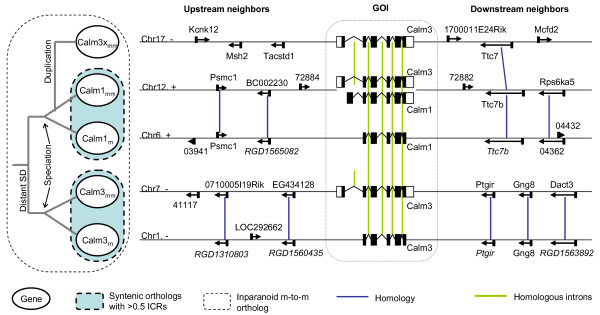
One example of many-to-many Inparanoid ortholog groups where a SD event proceeded mouse-rat speciation. The Ensembl gene IDs of GOI are ENSMUSG00000001175 (Calm1mm), ENSMUSG00000019370 (Calm3mm), ENSMUSG00000036438 (Calm3xmm), ENSRNOG00000004060 (Calm1rn), ENSRNOG00000016770 (Calm3rn). The gene structures and neighboring gene orders of five Calm1 and Calm3 genes in mouse and rat genomes are shown. The event tree on the left side is predicted based on the local synteny. SD: segmental duplication. Genes are shown corresponding to the strand of GOI in order to show the homology between neighboring genes. Five digits gene IDs are the last five digits of Ensembl gene IDs. IDs in italic typeset are predicted ones. Homology between two neighboring genes are defined by Blastp E-value < 1e-5.